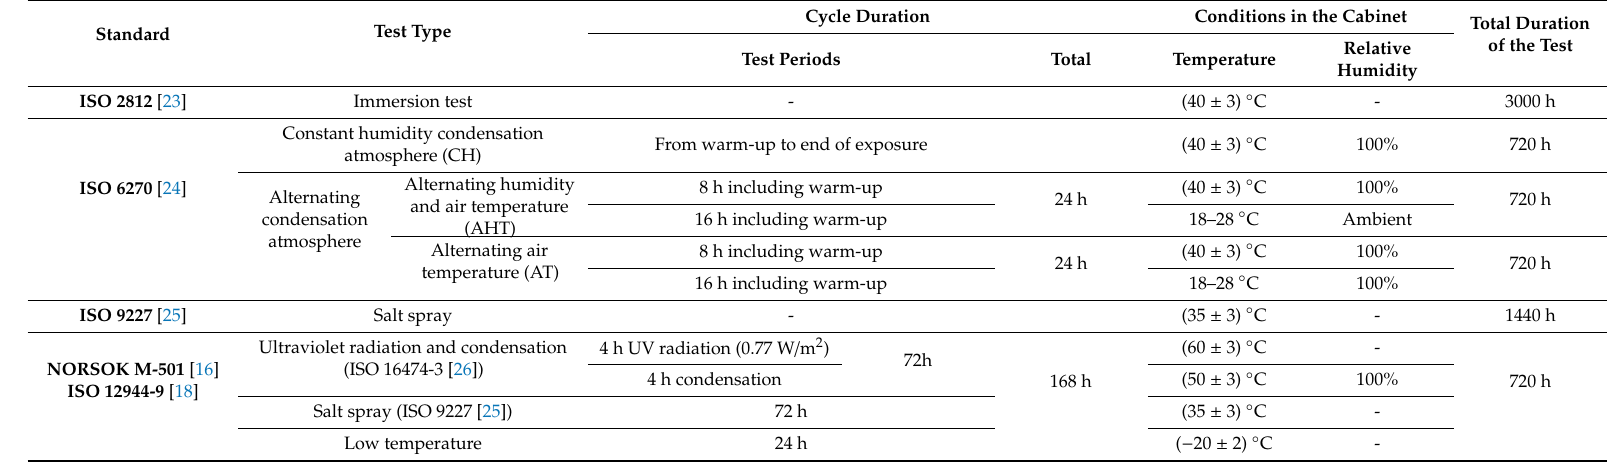
Table 4. Summary of the weathering corrosion aging test conditions in accordance with the di ff erent standards, and test duration for the C5-M and Im2 categories